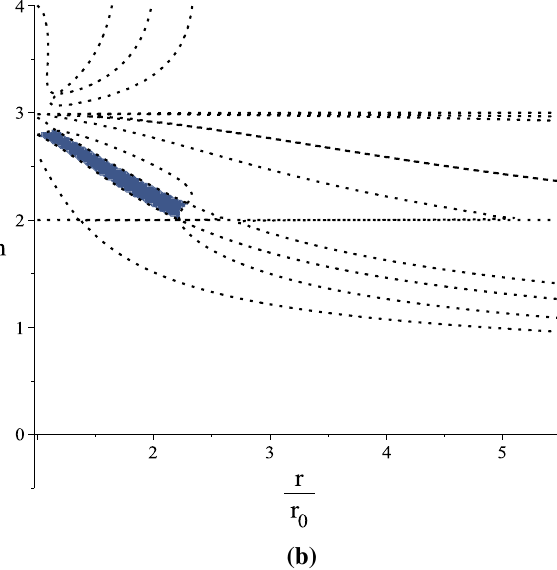
word we search for regions in n − r / r 0 diagram that (18) and conditions ii ), iii ) in (15) are satisfied and F in (20) takes a negative value